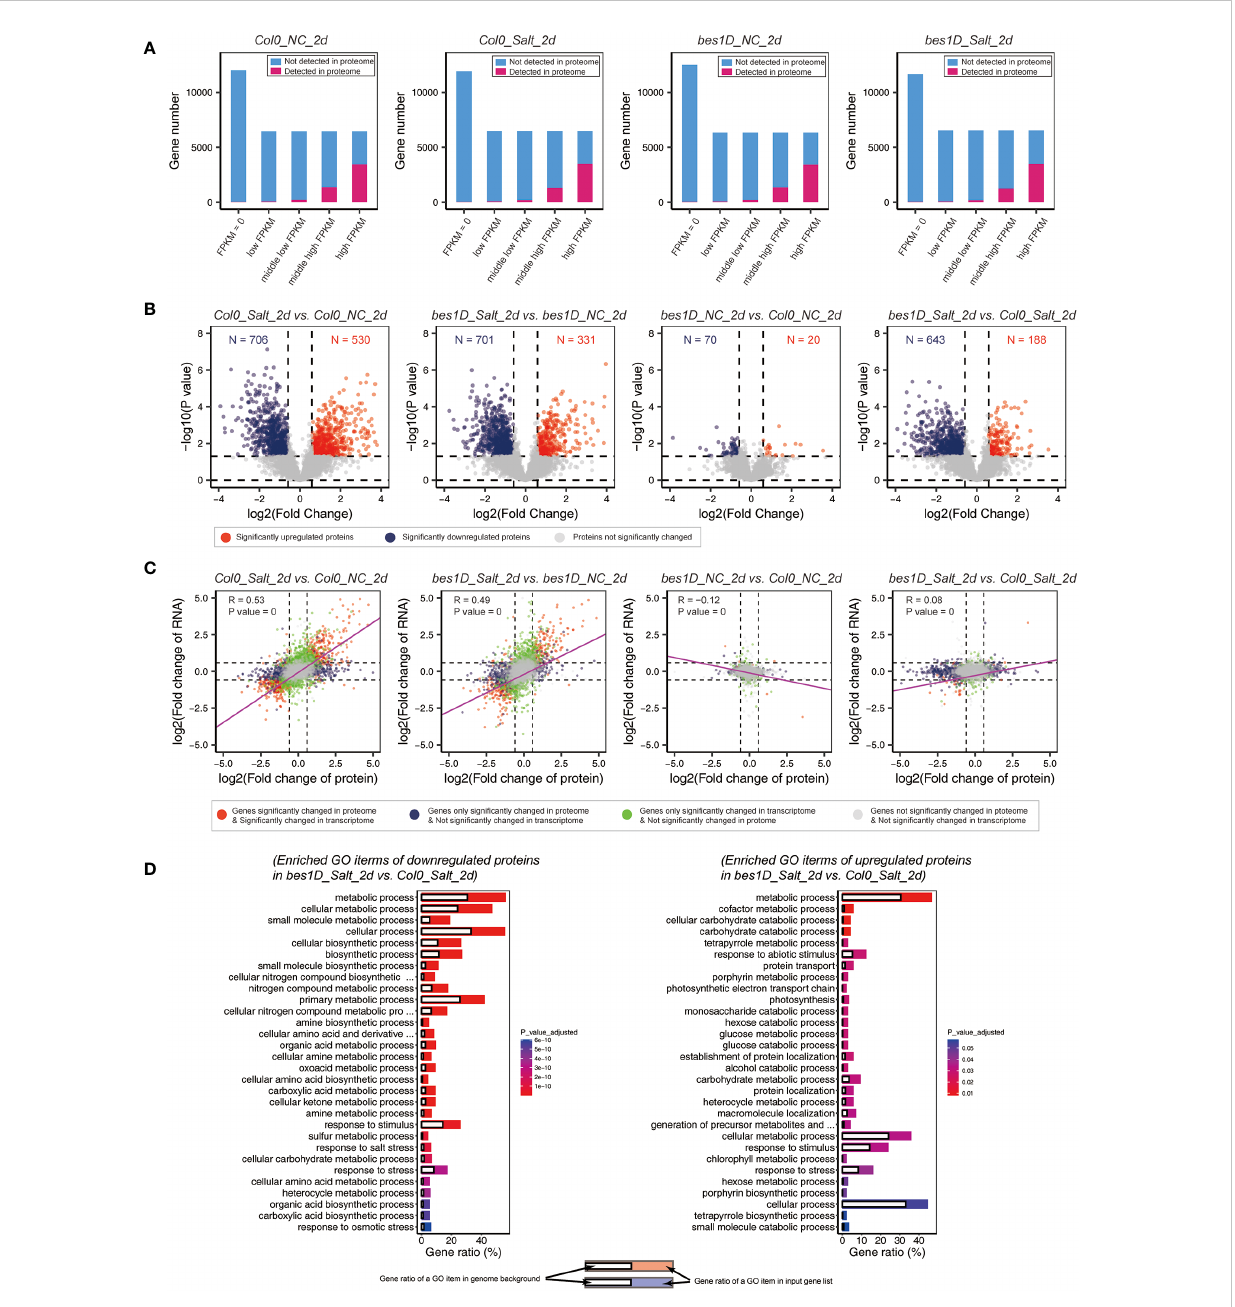
FIGURE 6 Proteomic analyses in bes1-D and Col-0 under salt stress. (A) Overlapping analysis of proteomic and transcriptomic data. All gene entries of A thaliana were classi fi ed into fi ve groups based on their RNA-level FPKM values. “ FPKM = 0 ” are genes that no reads were found in transcriptome. Expressed genes (FPKM > 0) were sorted by FPKM values and divided into four quarters: low FPKM, middle-low FPKM, middle-high FPKM, and high FPKM. Proteins identi fi ed in LC-MS/MS data were mapped to these fi ve categories. NC, normal conditions; Salt, 150 mM NaCl; 2d, 2 days of the treatment. (B) Volcano plot of all detected proteins in different comparisons. Fold change (absolute value) > 1.5 and P value < 0.05 were regarded as DEPs. Red, signi fi cantly upregulated genes; blue, signi fi cantly downregulated genes. (C) Correlation coef fi cient analysis of proteomic data and transcriptomic data. For genes both detected by RNA seq and LC-MS/MS, their fold changes were collected and transformed via log2, respectively. Pearson correlation coef fi cient between the two groups and its signi fi cance ( P value) were calculated by using rcorr package in RStudio. Linear regression (purple lines) was performed by using fi tting linear models ( lm function). (D) Gene Ontology enrichment analysis for downregulated and upregulated DEPs in bes1-D_Salt_2d vs. Col- 0_Salt_2d . Only top 30 Biological Process items were showed for each group due to the space